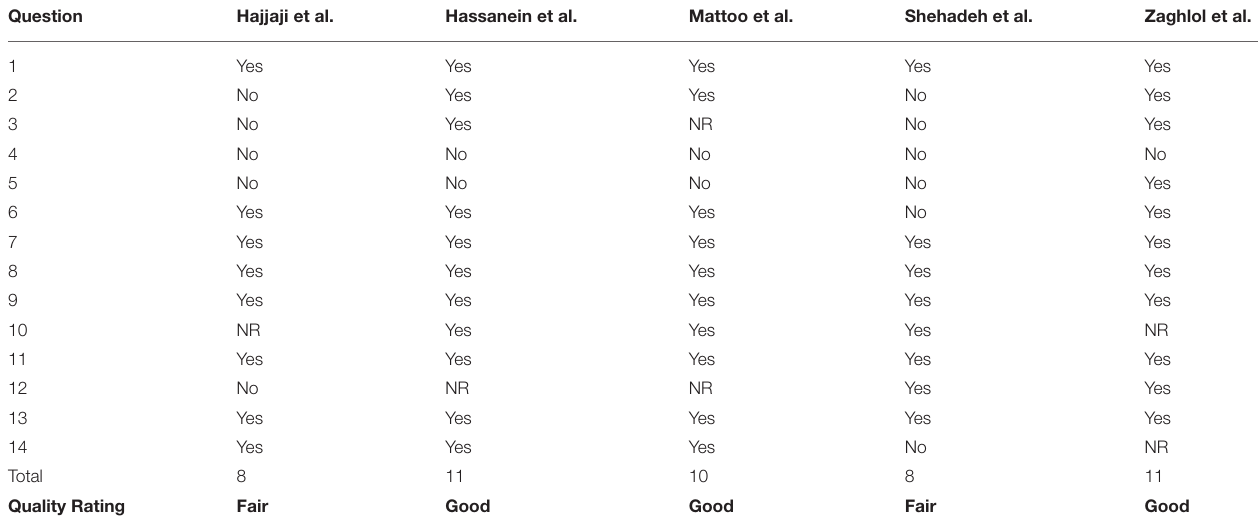
TABLE 6 | NHLBI risk of bias and quality assessment for controlled intervention studies.